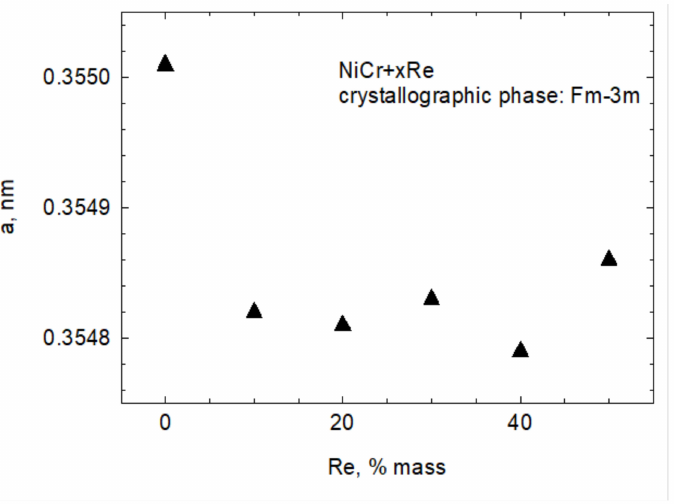
Figure 2. Changes in a cell parameter in relation to rhenium content in